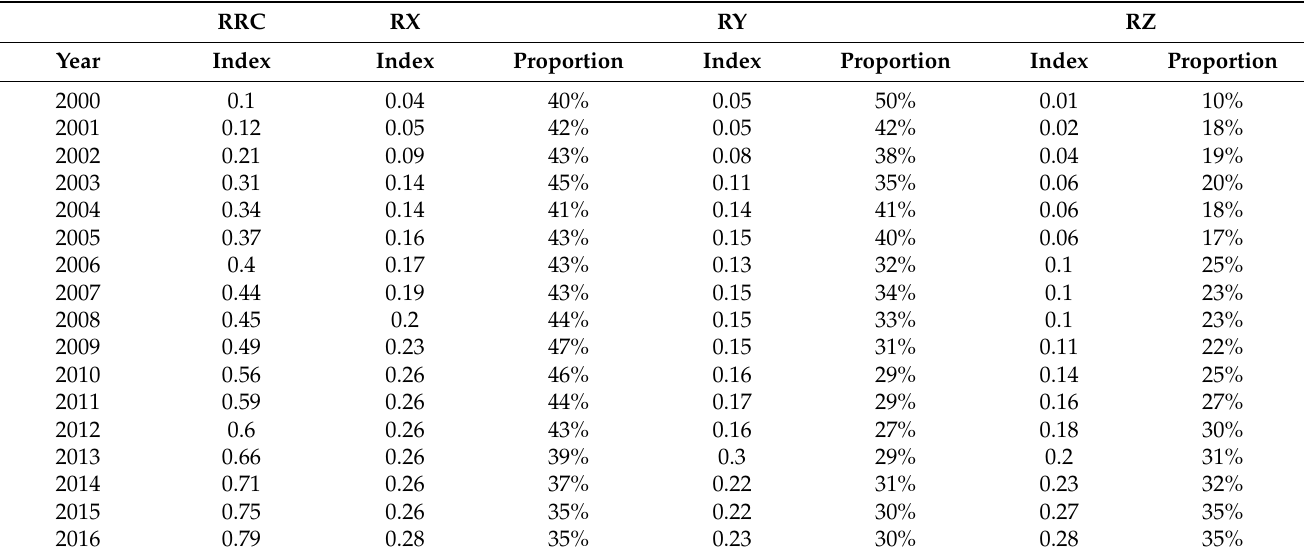
Table 2. Changes of rural restructuring index of Jianghan Plain from 2000 to